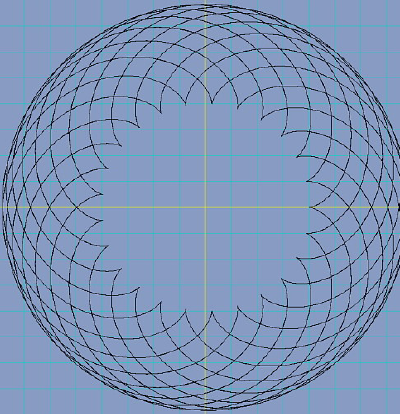
Figure 5. Epicycloid for values a = 200 and b = 97.